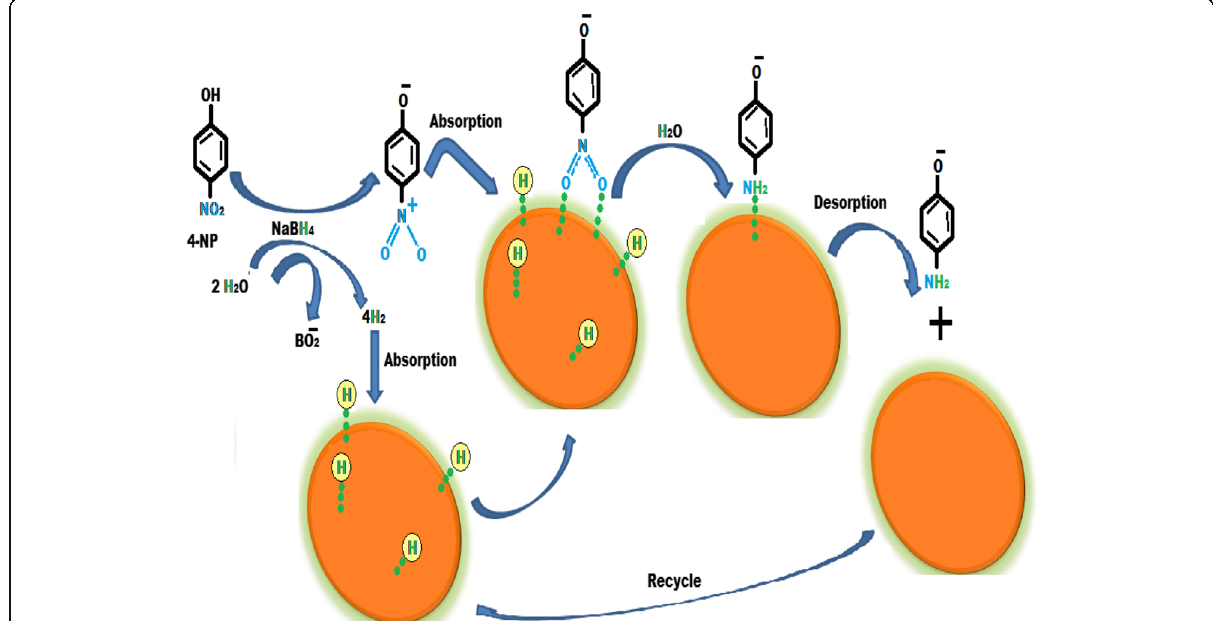
Fig. 7 Mechanism for the reduction of